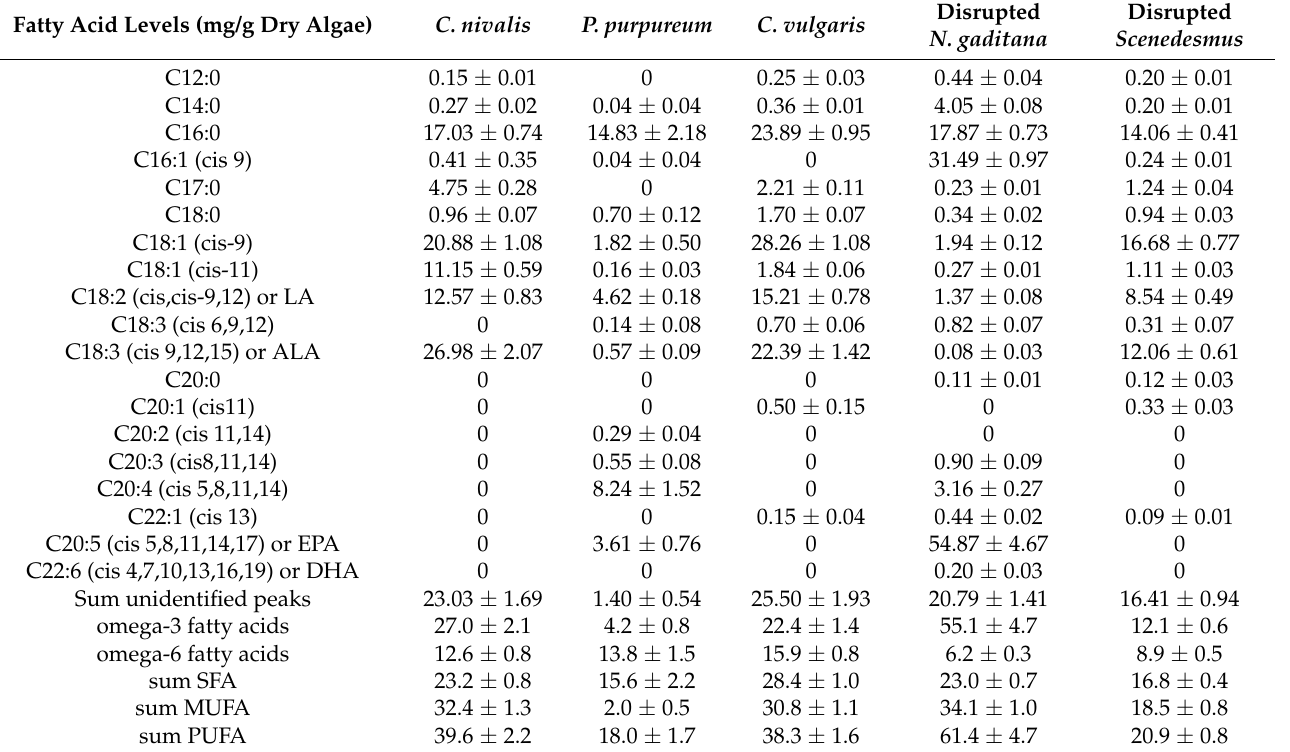
Table 2. Fatty acid concentrations (mg/g dry algae) in non-digested algae biomass. LA = linoleic acid, ALA = α -linolenic acid, EPA = eicosapentaenoic acid, DHA = docosahexaenoic acid, SFA = saturated fatty acids, MUFA = mono-unsaturated fatty acids, PUFA = poly-unsaturated fatty acids. Fatty Acid Levels (mg/g Dry